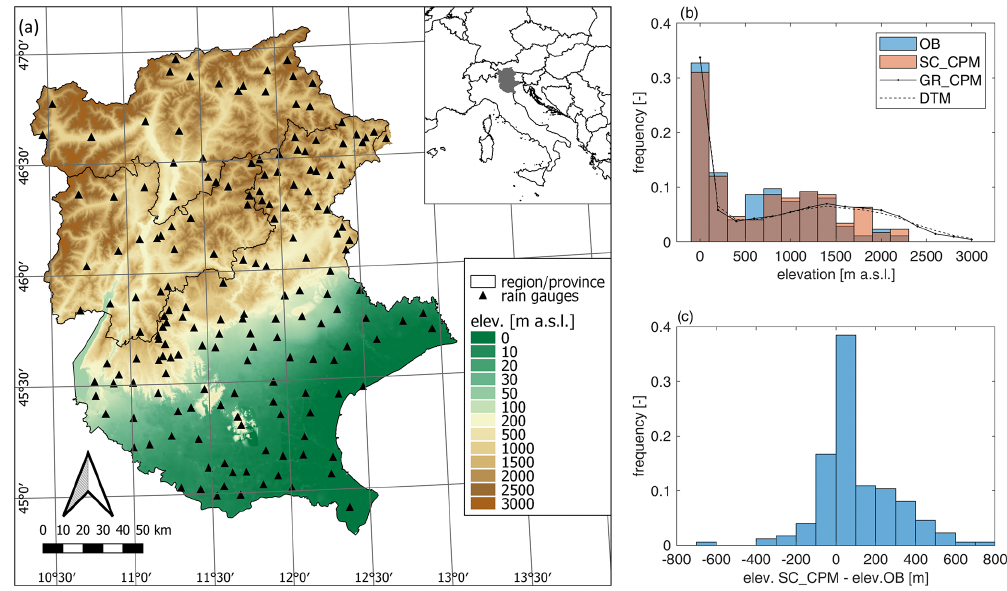
Figure 1. Study area and data. (a) Orography of the study area and location of the rain gauges; (b) frequency distribution of the elevation for the 174 rain gauges (observations; OB), the station-colocated CPM (SC_CPM), all the CPM grid points (GR_CPM), and the digital terrain model (DTM) for the study area; and (c) the distribution of the elevation differences between station-colocated CPM and